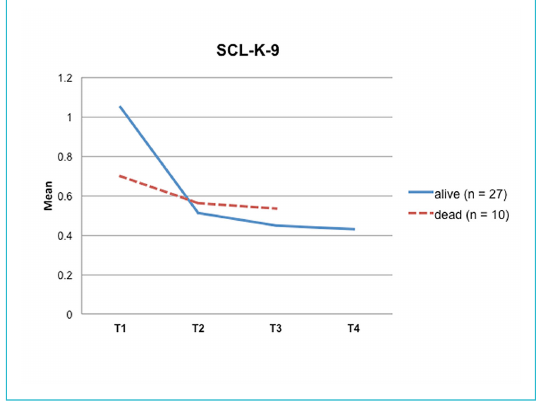
Figure 2: Psychological distress over time (T1 – T4). T0 = pre- transplant; T1 = two weeks post-transplant; T2 = three months